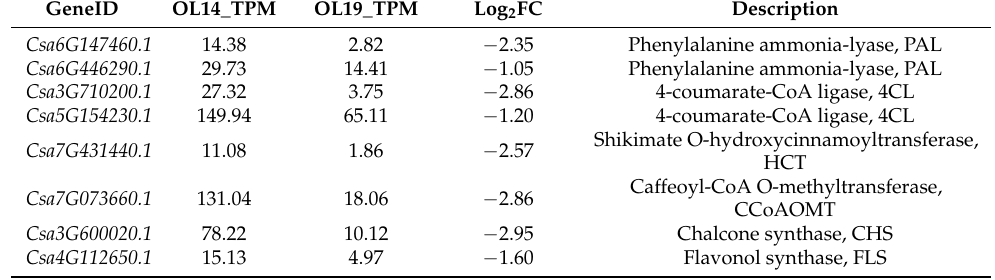
Table 2. Differential expression genes (DEGs) related to peel yellowing in OL14_vs_OL19.